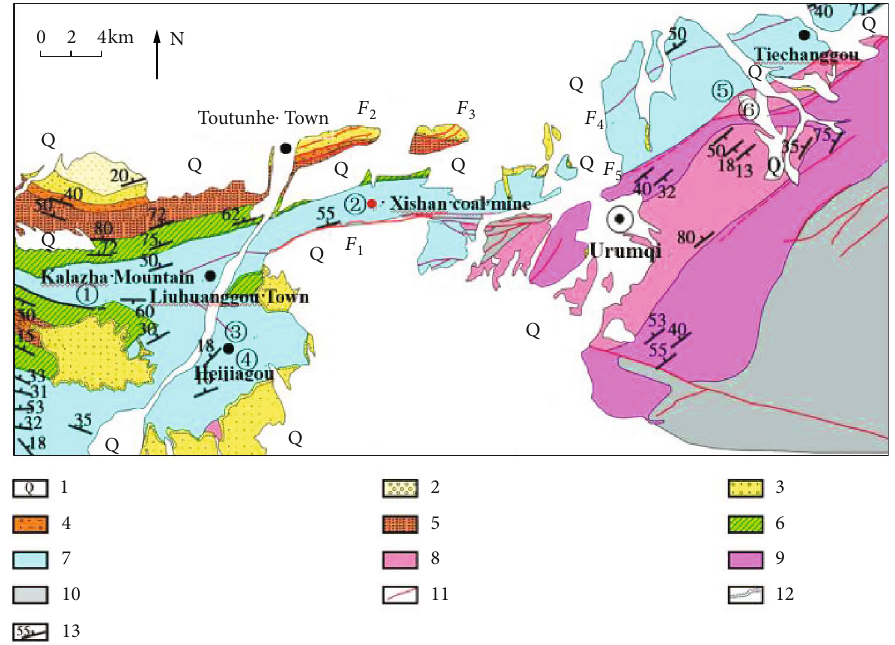
Figure 1: Map of coal geology in the region: 1: Quaternary, 2: upper section of Changji River Group, 3: lower middle section of Changji River Group, 4: front mountain group, 5: Upper Cretaceous and Lower Tertiary, 6: Lower Cretaceous Tugulu Group, 7: Jurassic, 8: Triassic, 9: Permian, 10: Pre-Permian, 11: fault, 12: unconformity, and 13: rock formation. ① : Kalaza anticline, ② : Xishan anticline, ③ : north small channel anticline, ④ : south small channel anticline, ⑤ : Qidaowan anticline, and ⑥ : Badaowan anticline. F fault, F : Jiujiawan fault, F : Wanyaogou fault, and F : Hongshanzui-Baiyanggou fault. 3 4 5